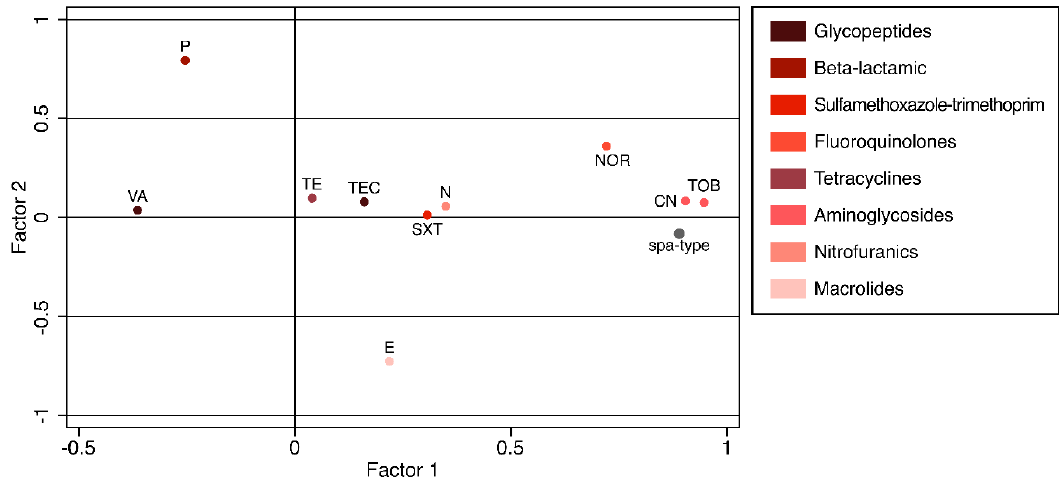
Figure 2. Loading plot showing the impact of each variable on the first two factors of the factor analysis. Legend: VA = Vancomycin; P = Penicillin G; TE = Tetracycline; TEC = Teicoplanin; E = Erythromycin; SXT = Sulfamethoxazole-Trimethoprim; N = Neomycin; NOR = Norfloxacin; CN = Gentamicin; TOB = Tobramycin.